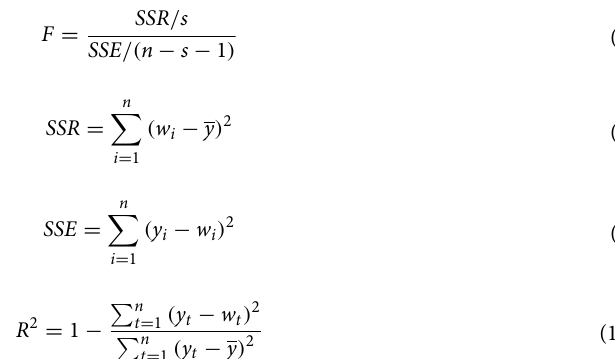
of k value is the minimum k value when the standardized regression coefficient of each independent variable becomes stable. The smaller the k value, the smaller the deviation, when the k value is 0, it is an ordinary linear OLS regression. (ii) Manually input k value for regression modeling. For the k value, generally the smaller the better, and it is generally recommended to be less than 1.After determining the k value, we can manually enter the k value to get the LASSO regression model estimate. For the LASSO regression model of O 3 concentration prediction, it can be seen from Fig. 4 that when k = 0.05, the standardized regression coefficients of each independent variable tend to be stable, so this paper takes k = 0.05 to establish the LASSO regression model. In the model, PM 2.5 concentration, CO concentration, SO 2 concentra- tion, pressure and precipitation have no effect on O 3 concentration, so they are excluded from the model.